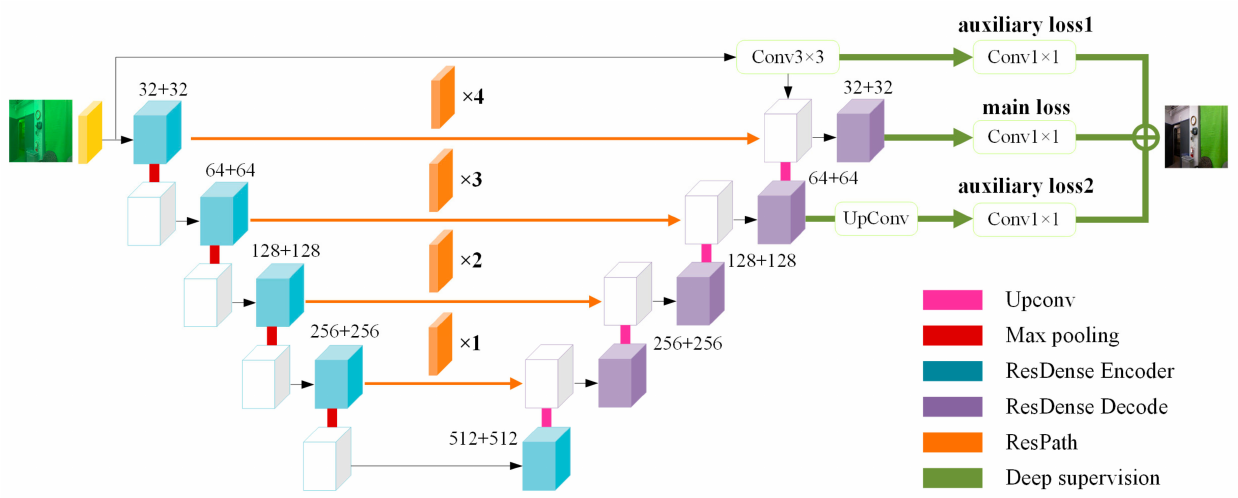
Figure 4. DS_RD_Net architecture. DS_RD_Net adds residual dense blocks, residual path blocks, and a deep supervision mechanism to learn the mapping relationship between clear in-air images and synthetic underwater degraded